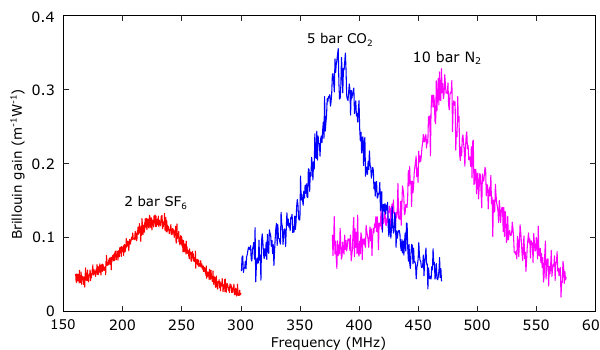
Fig. 6 Experimental Brillouin gain spectra from the nano fi bre gas cell fi lled with different types of gas. Measured Brillouin gain spectra for 2 bar SF 6 , 5 bar CO 2 and 10 bar N 2 . For the CO 2 and N 2 measurements, the noise equivalent bandwidth of the electrical spectrum analyser (ESA) is 1 kHz, while for the SF 6 measurement, the noise equivalent bandwidth of the ESA is 100